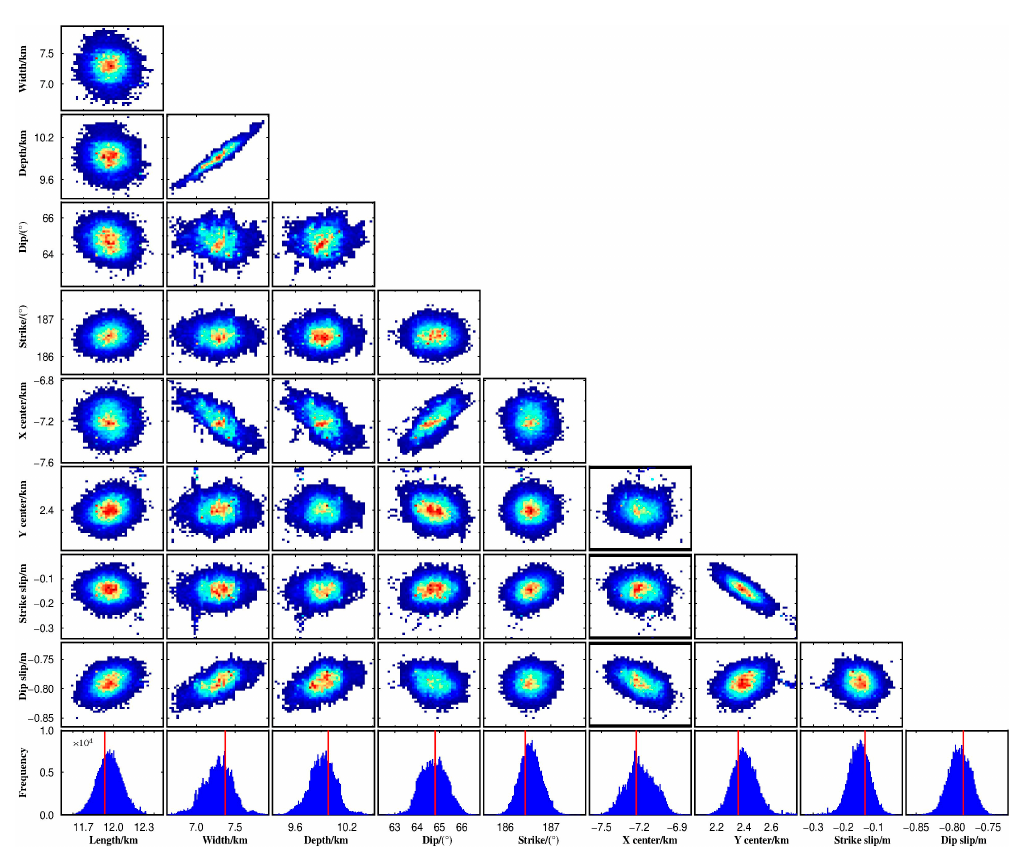
Figure 7. Fault model parameters estimated by posterior probability distribution of the Bayesian approach for the Mw 6.2 Yutian earthquake in 2020. Red lines represent optimal model parameter solutions. Table 3. Source parameters of the 2020 Yutian earthquake.